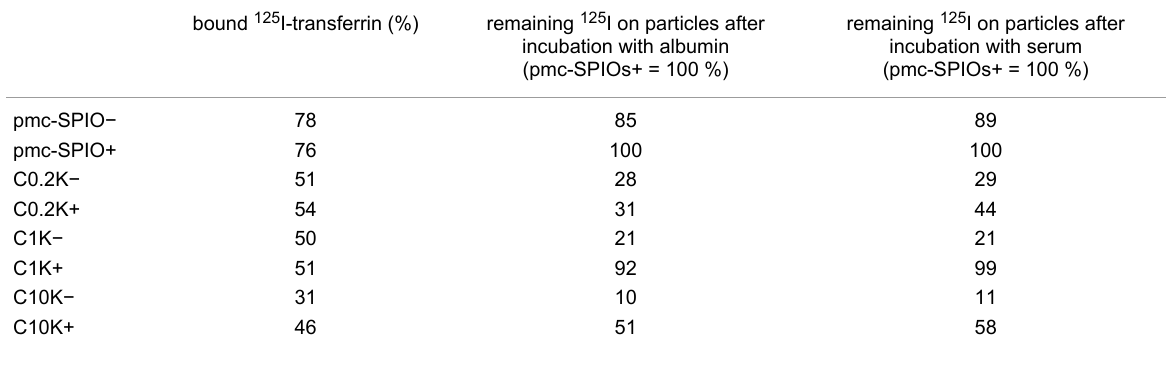
Table 1: Binding of 125 I-transferrin to different PEGylated SPIOs. C0.2K denotes a partly PEGylated SPIO with EDC in the synthesis (SPIO:EDC = 1:200); C10K, a fully PEGylated SPIO with SPIO:EDC 1:10000. +, EDC present in the initial transferrin coupling (SPIOs:EDC 1:1000); − , adsorbed transferrin with no EDC